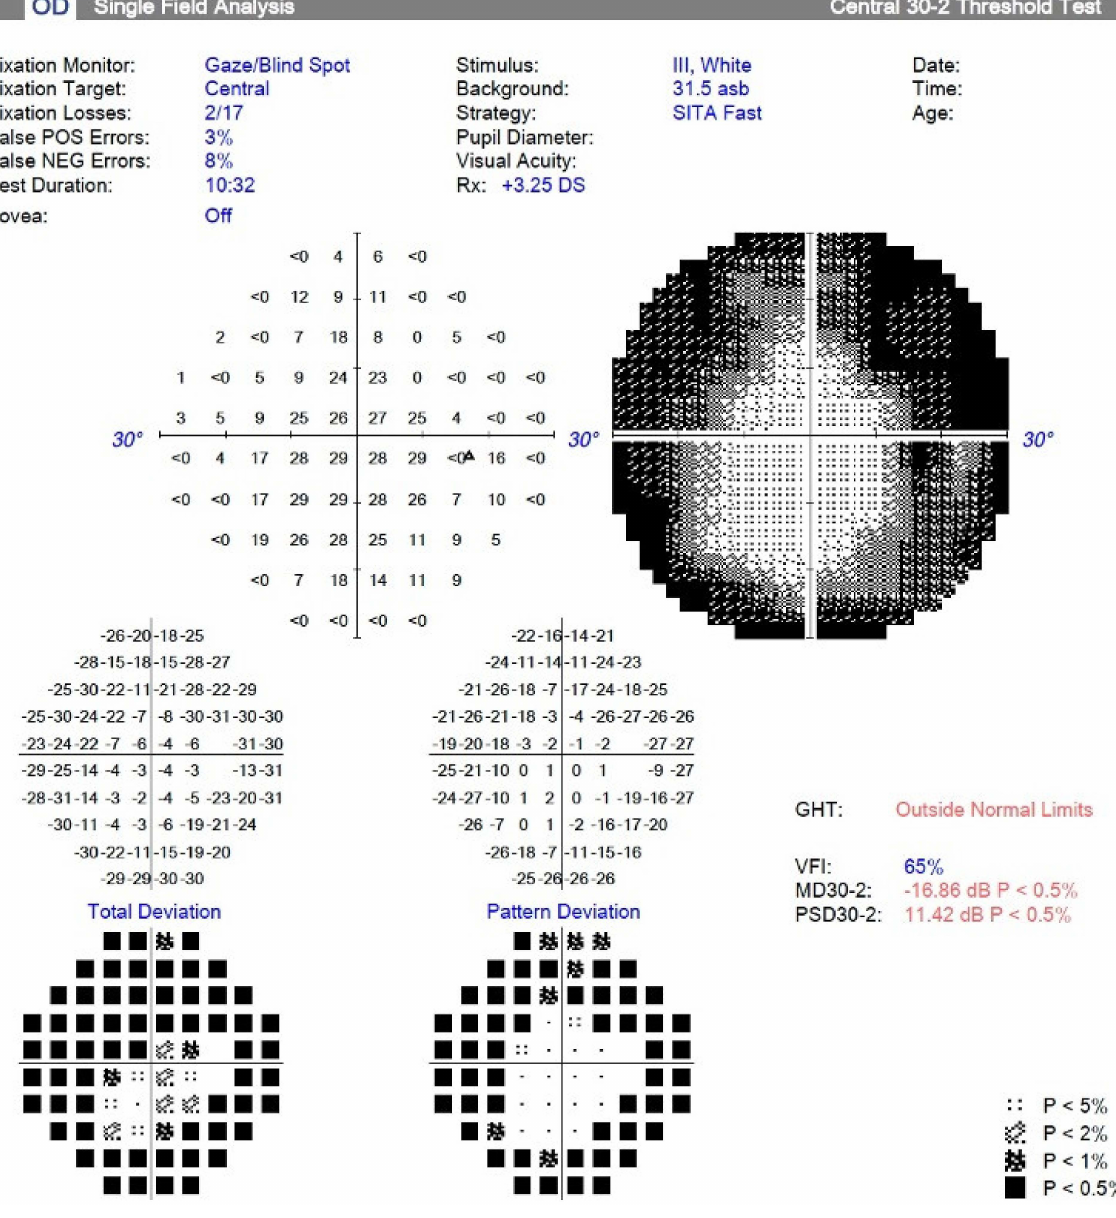
Figure 1. Printout of automated visual field testing showing concentric